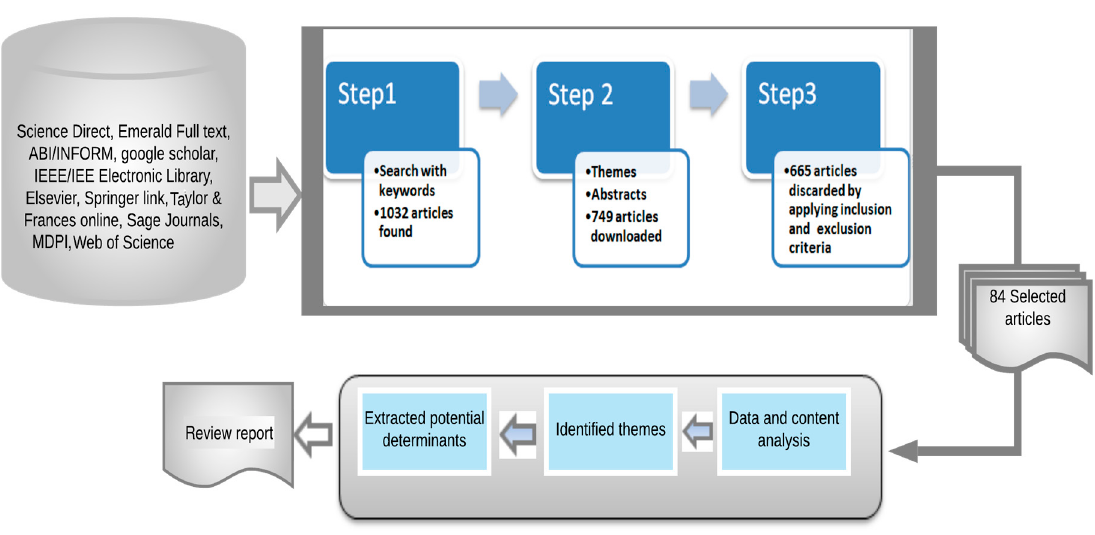
Figure 1. Papers selection and analysis process.